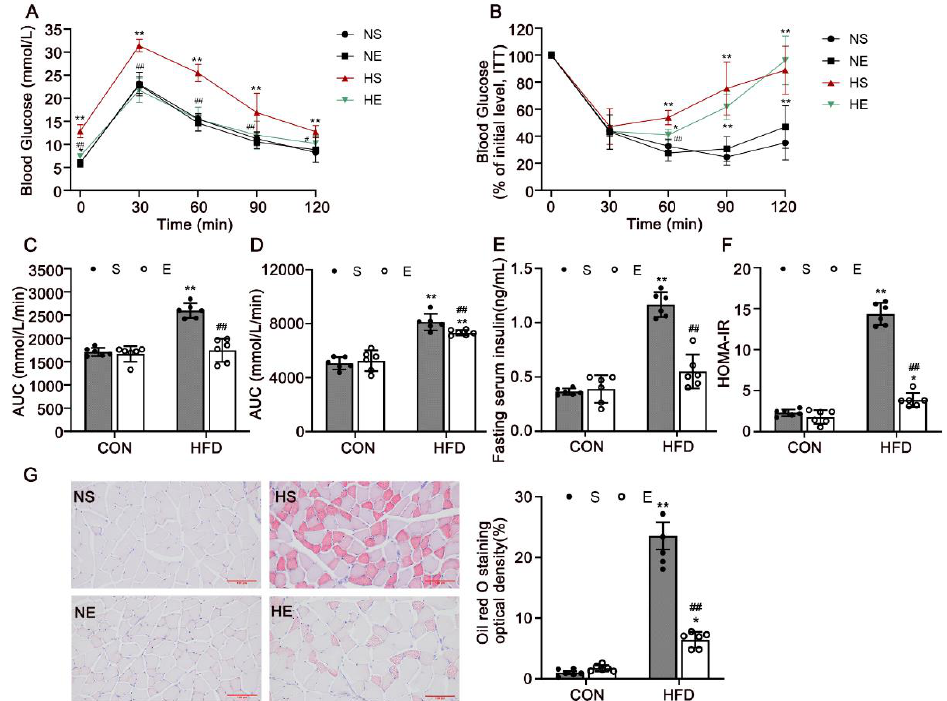
Figure 3. Aerobic exercise improved HFD-induced insulin resistance and dyslipidemia. ( A ) GTT. ( B ) Insulin tolerance test (ITT). ( C ) AUC of GTT. ( D ) AUC of ITT. ( E ) Serum insulin level of mice fasted for 12 h. ( F ) The value of HOMA-IR. ( G ) Oil Red O staining of lipid droplets in skeletal muscle (scale bar = 100 μm). CON, normal control; HFD, high-fat diet; S, sedentary; E, exercise. NS, normal sedentary; NE, normal + exercise; HS, HFD sedentary; HE, HFD + exercise. * p < 0.05, ** p < 0.01 vs. NS group; # p < 0.05, ## p < 0.01 HS group. Table 2. Effects on metabolic parameters after eight weeks of aerobic exercise.